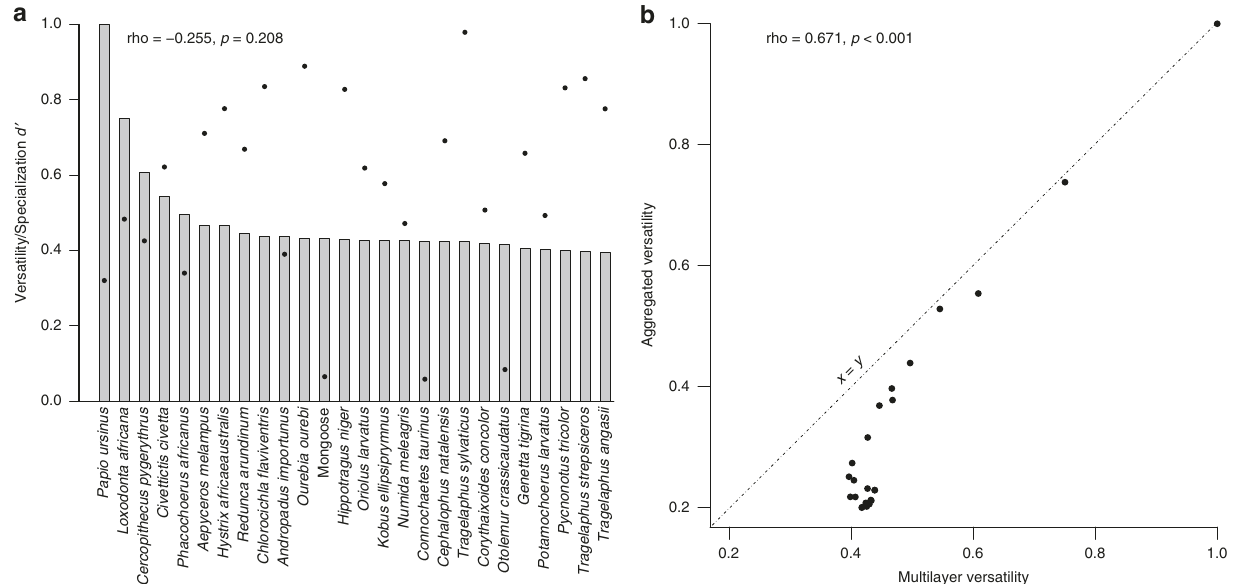
Fig. 5 Correlates of multilayer versatility. Correlation between animal species versatility in the multilayer network (bars) and the mean specialization d ’ (dots) ( a ), and between multilayer versatility of the monolayer versatility of the aggregated network ( b ). Full data available in Supplementary Table 4